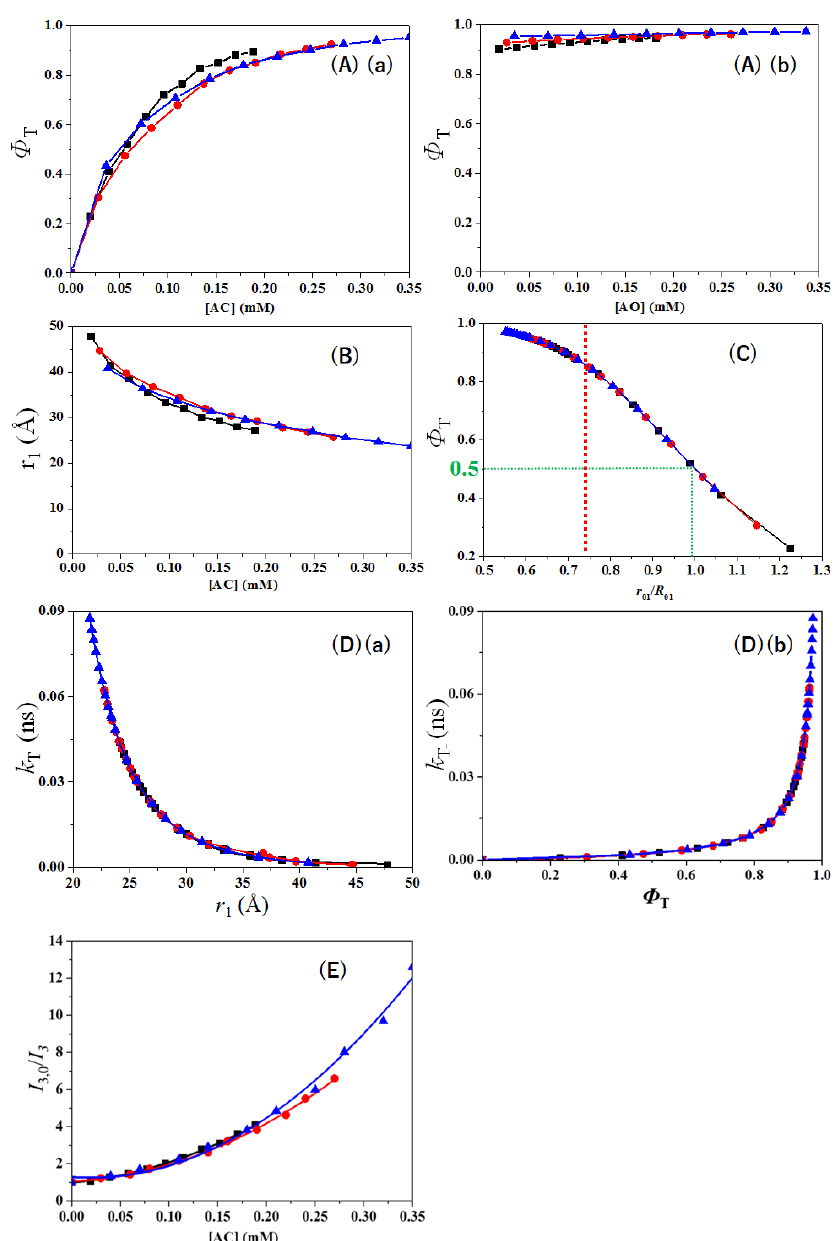
Figure 6. ( A ) Energy transfer efficiency of Py versus concentration of ( a ) AC and ( b ) AO. ( B ) Distance between Py and AC versus concentration of AC. ( C ) Energy transfer efficiency of Py versus r 1 /R 01 . ( D ) Rate constant of Py versus ( a ) distance between Py and AC and ( b ) energy transfer efficiency of Py. ( E ) I 3,0 /I 3 for the third emission band of Py versus concentration of AC. Mother solution: Py(3.5 µ M)-AC(4.9 mM)-AO(4.9